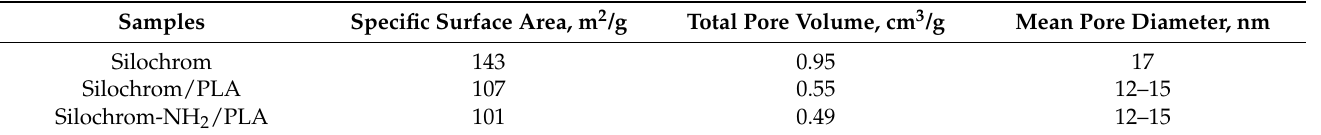
Table 1. Structural characteristics of the composites.